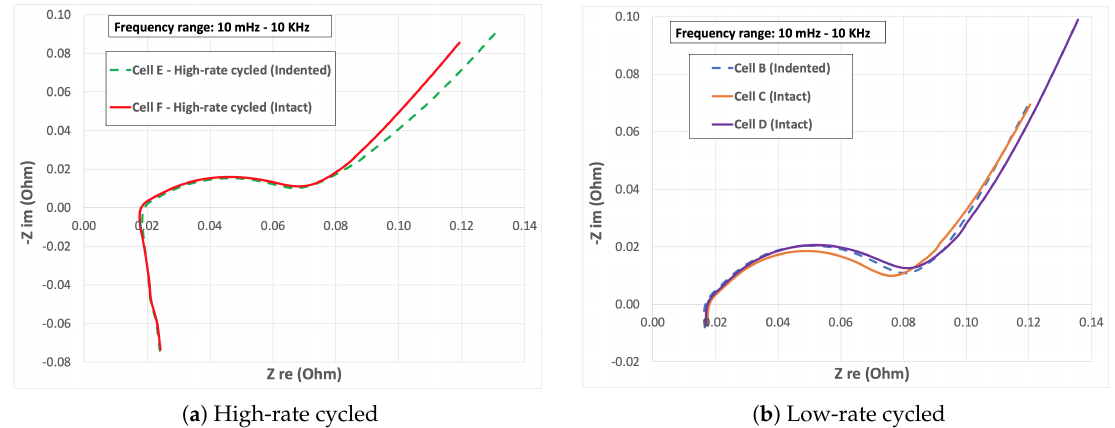
Figure 8. EIS plots of high-rate tested cells as described in Section